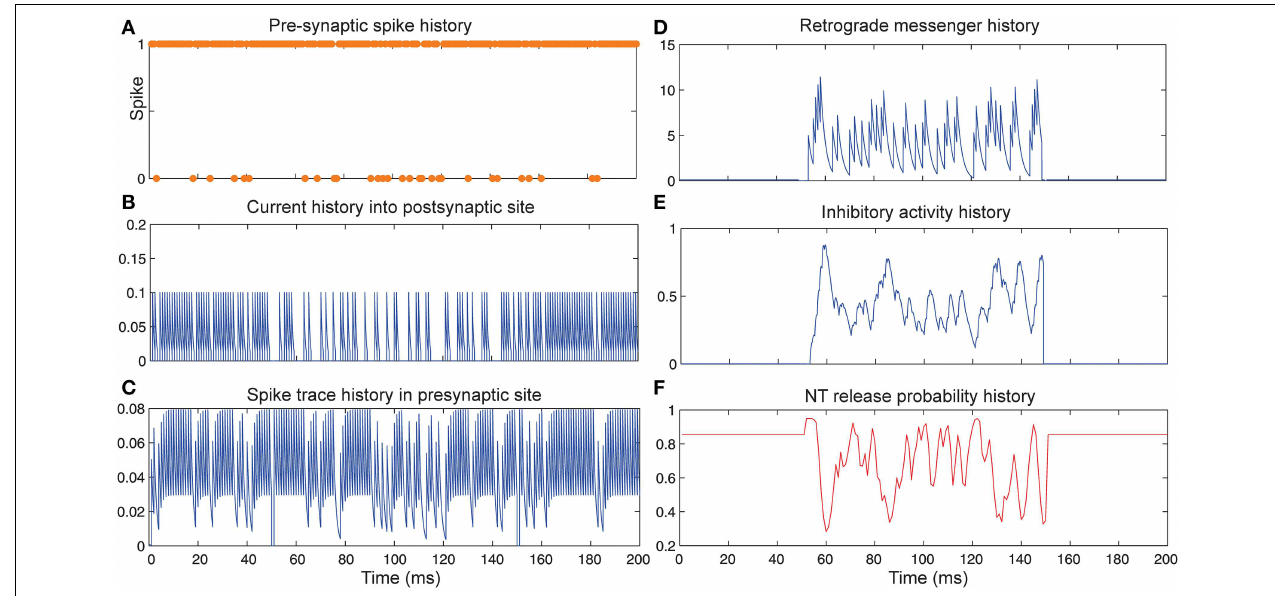
FIGURE 4 | The Dynamics of model’s parameters in the presence of homeostatic regulation of neurotransmitter release and absence of Hebbian mechanism. (A) Spike train history of a presynaptic neuron with firing probability equal to 0.85 in 200 time bins. (B) Current history into the postsynaptic site triggered by presynaptic neuron’s spiking. In time bins between 50 and 150 homeostatic regulation of neurotransmitter release was applied by generation of retrograde messenger in the postsynaptic site and its effect in